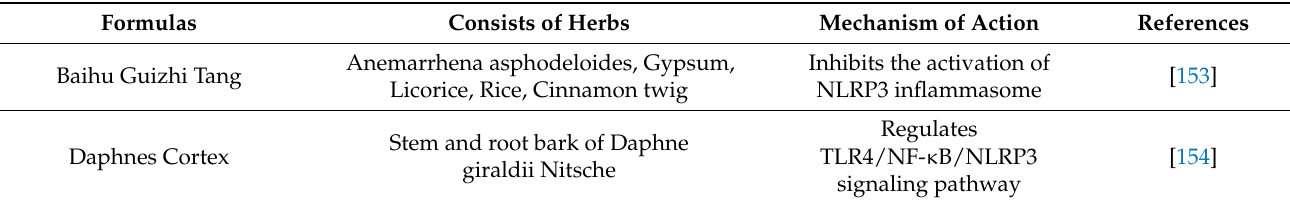
Table 5. TCM formulas as inhibitors of